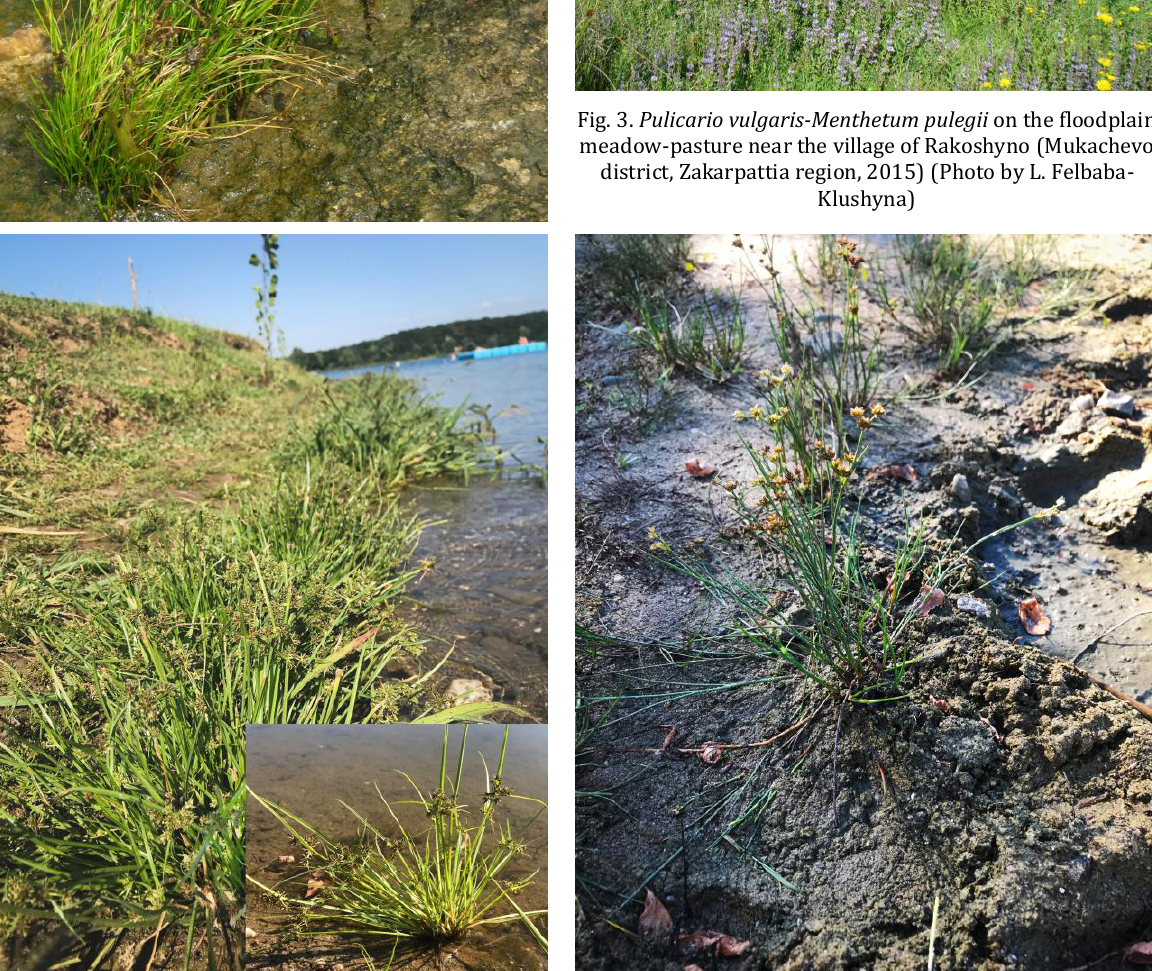
Fig. 5. Juncus articulatus on the periphery of the reservoir (near the village of Dyidovo, Beregiv district, Zakarpattia region, 110 m above sea level, 12.08.2020) (Photo by L.